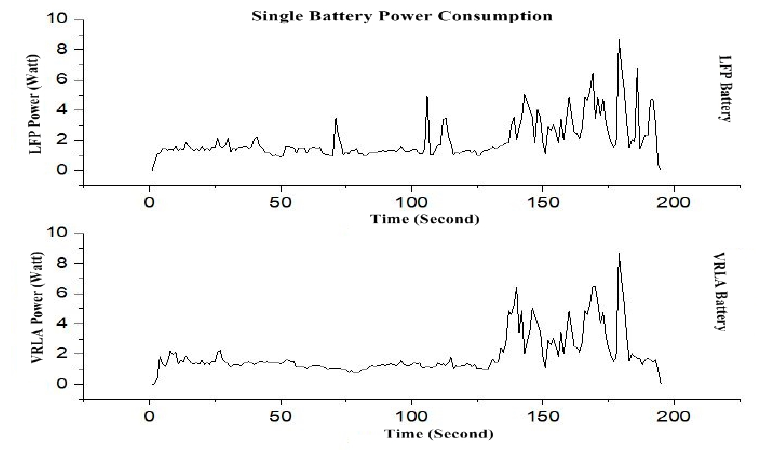
Figure 18. Single battery power consumption of VRLA and LFP graph.